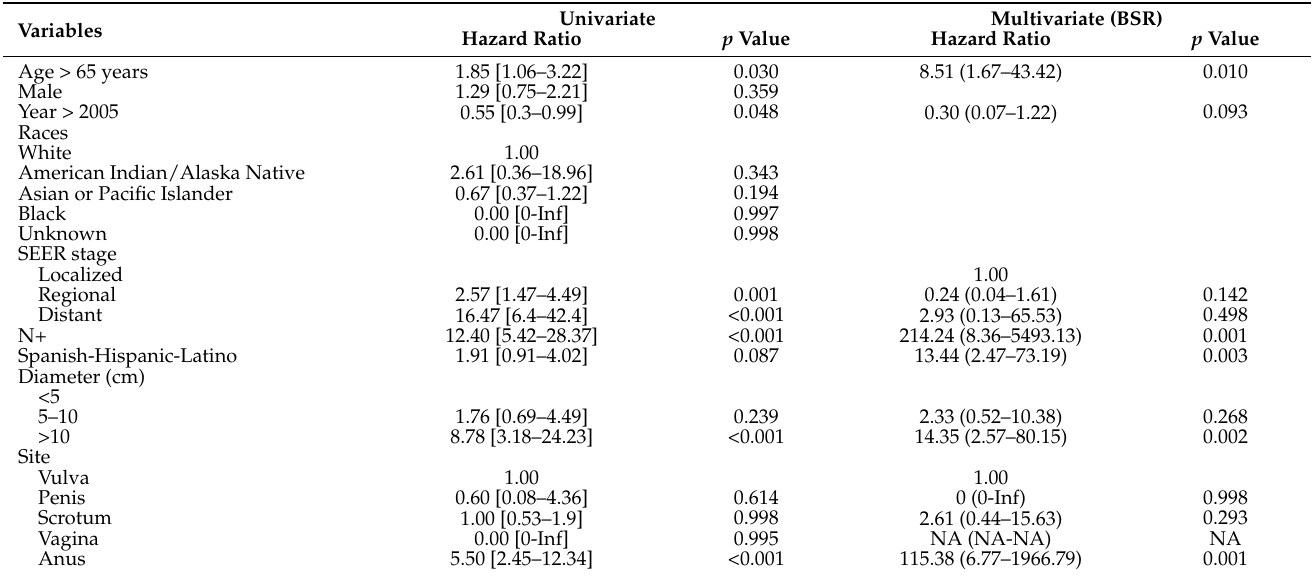
Table 1. Univariate and multivariate (backward stepwise) Cox regression for cancer-specific survival (CSS) in